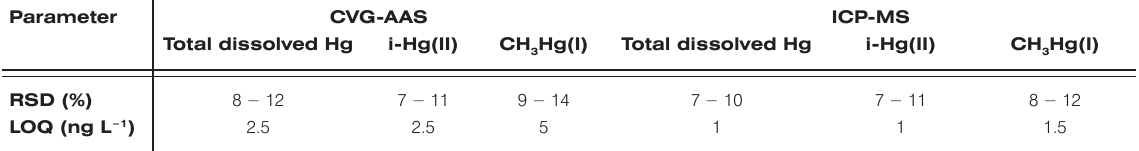
Table 2. Recovery test for spiked surface water samples (mean of 3 measurements ± sd.). Eluents: 4 mol L −1 HCl for CH thiourea in 0.1 mol L −1 HCl for i-Hg(II). Sample